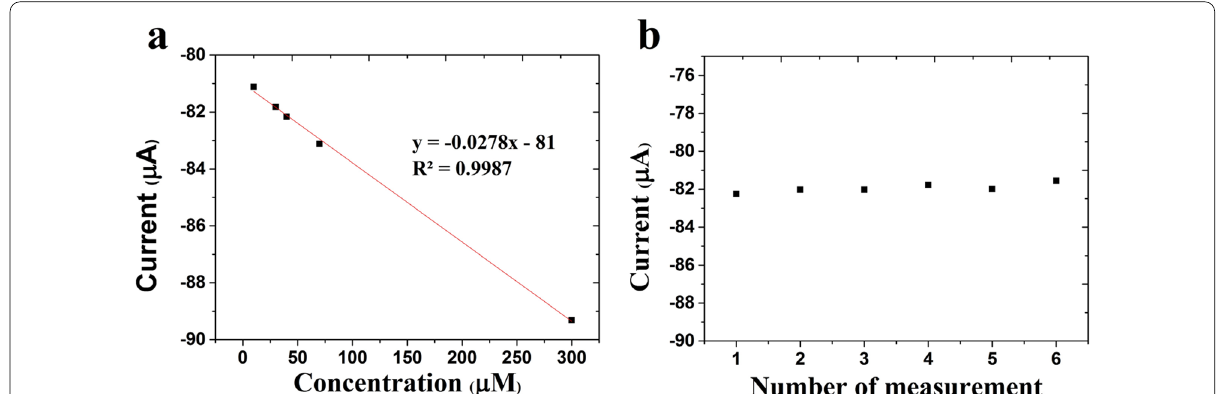
Fig. 5 a Calibration curve of the 3TC concentration versus the reduction peak current and b repeatability studies of GCE/ZnO NPs for 3TC in 0.1 M PBS (pH